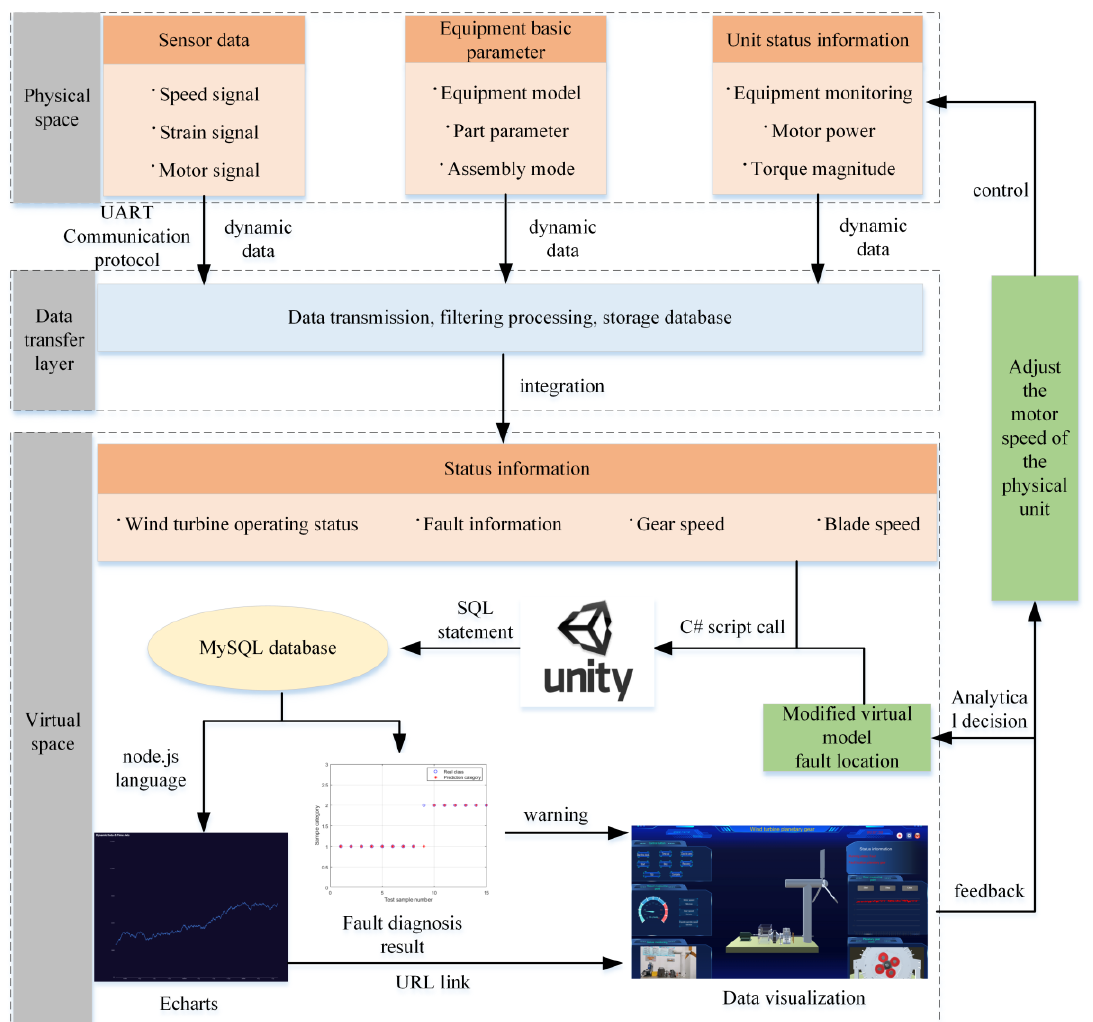
Figure 5. Architecture of the digital twin of the wind turbine drive system.